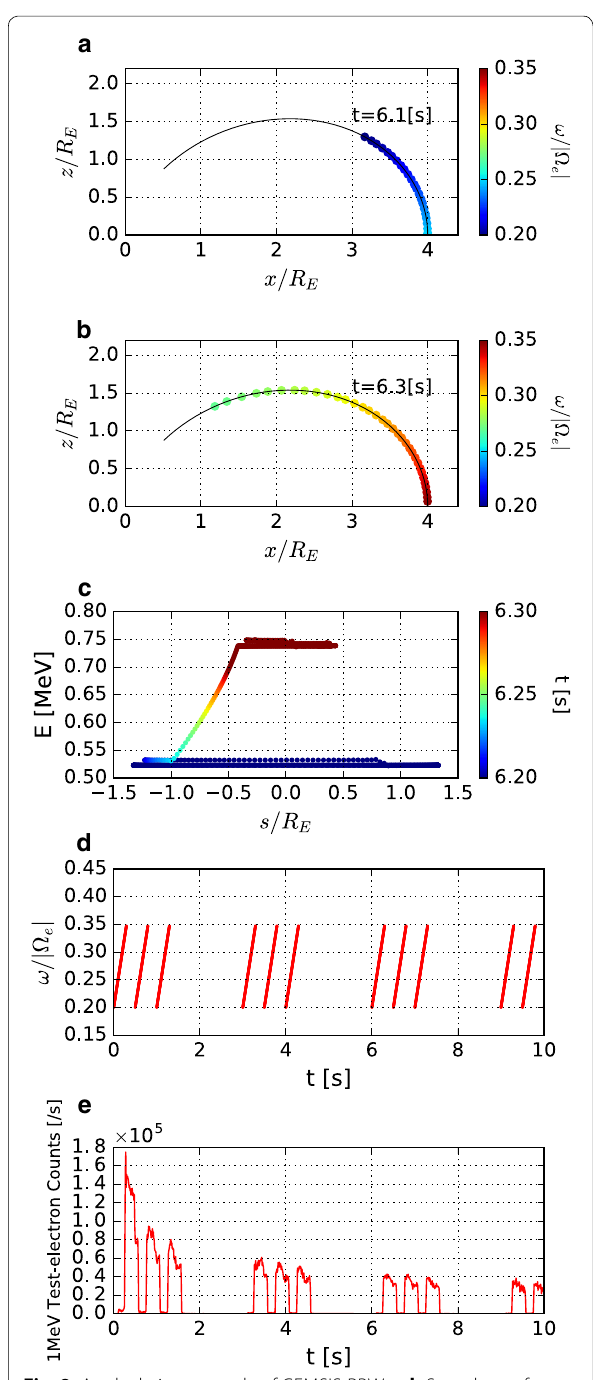
Fig. 8 A calculation example of GEMSIS‑RBW. a , b Snapshots of whistler‑mode chorus waves propagating along the magnetic field line (solid line) at t 6.1 and 6.3 s. The color of solid circles shows fre‑ = quency of wave packet. c Trajectory of an electron during t 5 and = t 7 s in ( s , E ) plane, where s is distance from the equator along the = magnetic field line and E is kinetic energy. The color of solid circles shows the time between 6.2 and 6.3 s. d Applied dynamic spectrum of whistler chorus elements. e Temporal variation of counts of 1 MeV electrons precipitated into the atmosphere (100 km